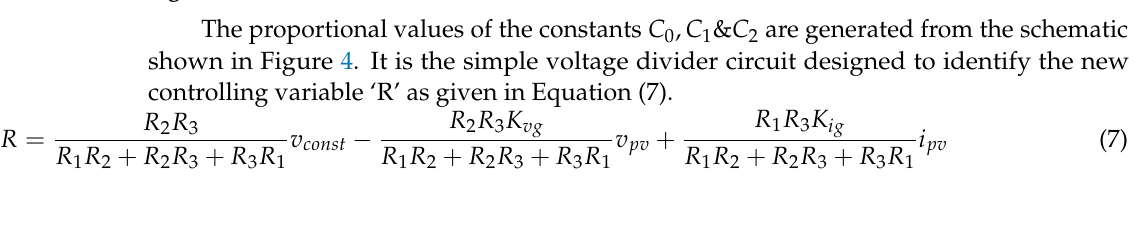
Figure 3. V-I and V-R characteristics for different PV temperature.